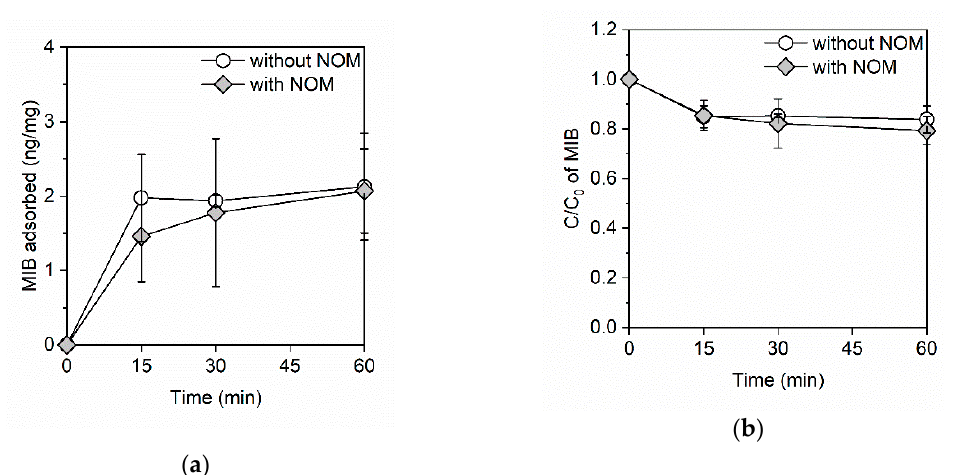
Figure 2. ( a ) The amount of adsorbed MIB and ( b ) the residual ratio of MIB on the GO in the absence and presence of NOM. The GO and NOM concentrations were 100 mg/L and 3.5 mg C/L, respectively. The initial concentration of MIB was ∼ 1 μ g/L and the initial pH was 7.4.